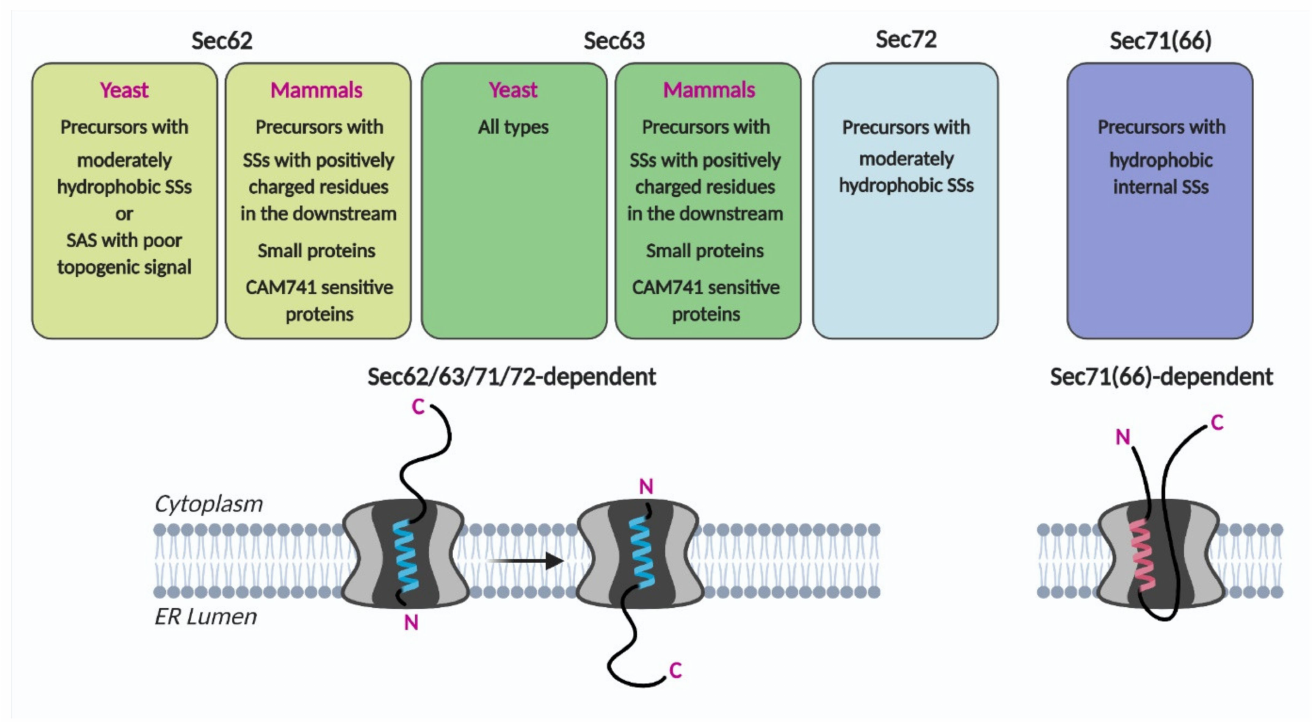
Figure 3. Sec62/Sec63 substrate specificity. Precursors having indicated characteristics may preferably insert the translocon as head-on and then invert (Sec62/63/71/72-dependent) or as a loop conformation (Sec71(66)-dependent). SS, signal sequence; SAS, signal-anchored